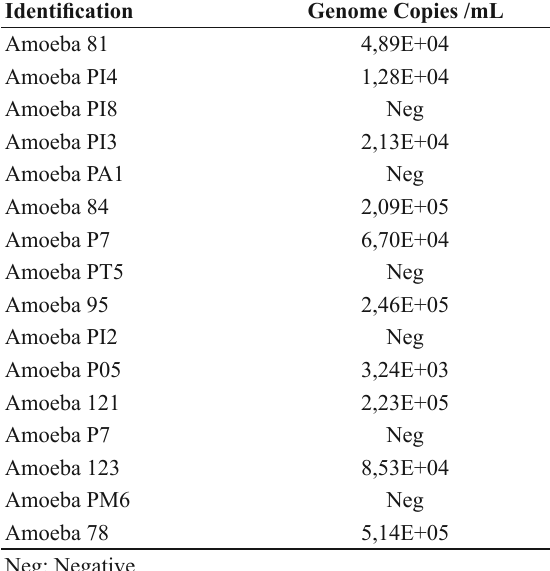
Detection of HAdV in Isolates of Acanthamoeba